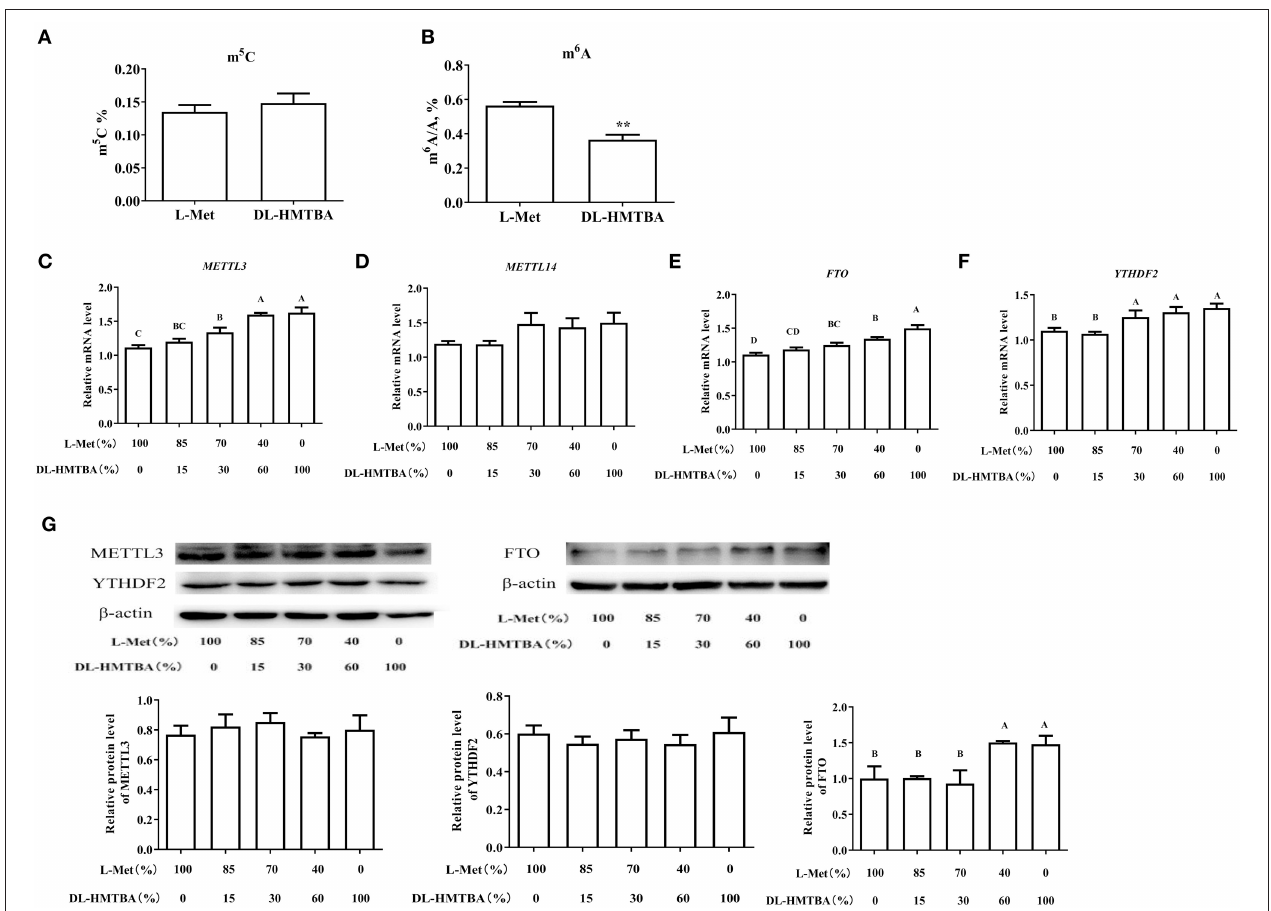
FIGURE 5 | Effects of L-Met and DL–HMTBA on methylated modification in IPEC-J2 cells. (A) Total m 5 C level; (B) Total m 6 A level; (C) mRNA levels of METTL3 (methyltransferaselike 3); (D) mRNA levels of METTL14 (methyltransferaselike 14); (E) mRNA levels of FTO (Fat mass and obesity-associated protein); (F) mRNA levels of YTHDF2 (YT521-B homology domain family 2); (G) Protein levels of RNA methylation-related proteins. Cells were cultured without fetal bovine serum for 18h and then without Met for 6h, then, different ratios of L-Met and DL–HMTBA were given for 2h (total methionine source concentration is 5mM). Values are means ± SEM, n = 3; different letters (A–D) mean the difference is extremely significant, * p < 0.01; ** p <